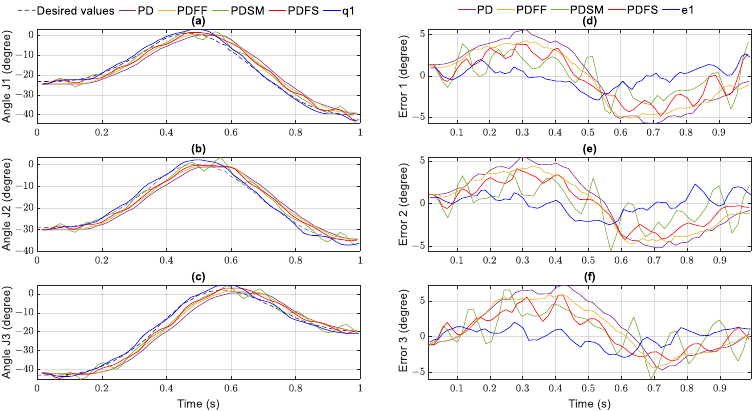
Figure 13. Parabolic trajectory performance in joint space: ( a ) joint 1; ( b ) joint 2; ( c ) joint 3 and tracking error: ( d ) joint 1; ( e ) joint 2; ( f ) joint 3 in the experiment case 1.